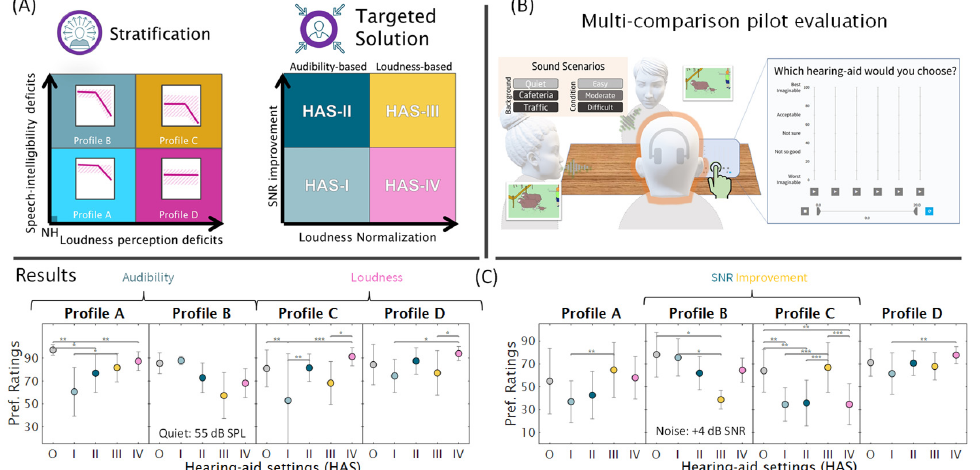
Figure 1. Overview of the pilot evaluation of the BEAR fitting strategy. ( A ) Stratification of the listeners into profiles A–D is based on two largely independent auditory dimensions, that is, speech intelligibility deficits and loudness perception deficits. Four tailored solutions (HAS I-IV) were proposed to compensate for these deficits using SNR improvement and loudness normalization, respectively. ( B ) Perceptual evaluation carried out with a HA simulator. ( C ) Results suggest that profile-C and -D listeners prefer their tailored solutions over a standard solution (HAS O), whereas profile-A and -B listeners do not show a clear preference. The image is based on the graphical abstract of [8] .